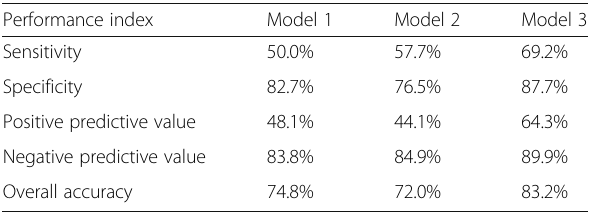
Table 3 Comparison of prediction performance of three machine learning models trained using tumor-related features (Model 1), emphysema-related features (Model 2),